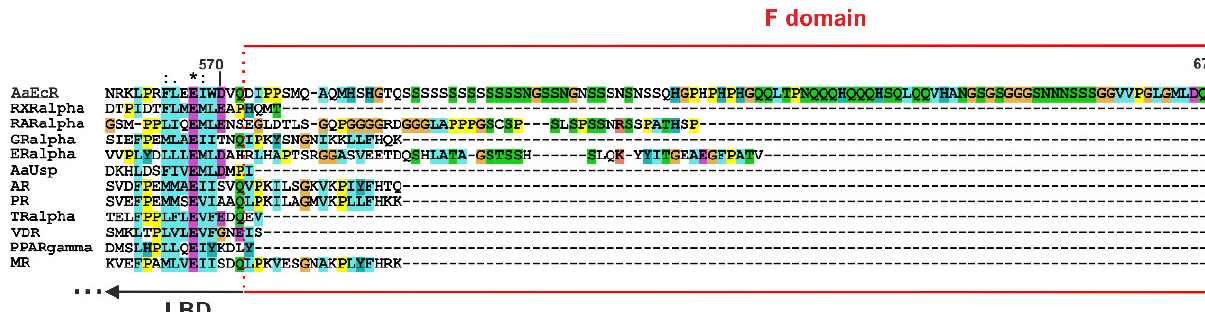
Figure 2. The F domains of various nuclear receptors are not evolutionarily conserved. The used abbreviations and the UniProt accession numbers (in parentheses) are as follows: A. aegypti EcR (AaEcR, GenBank: AAA87394.1), human retinoid X receptor α (RXRα, UniProt: P19793), human all-trans retinoic receptor (RARα, UniProt: P10276), human glucocorticoid receptor α (GRα, UniProt: P04150), human estrogen receptor α (ERα, UniProt: P03372), A. aegypti Usp protein (AaUsp, UniProt: Q9GSG7), human androgen receptor (AR, P10275), human progesterone receptor (PR, UniProt: P06401), human thyroid hormone receptor (TR, UniProt: P10827-2), human vitamin D receptor (VDR, UniProt: P11473), human peroxisome proliferator-activated receptor γ (PPARγ, UniProt: P37231), and human mineralocorticoid receptor (MR, UniProt: P08235). Residue numbering corresponds to the sequence of AaEcR (GenBank: AAA87394.1). Sequences corresponding to the F